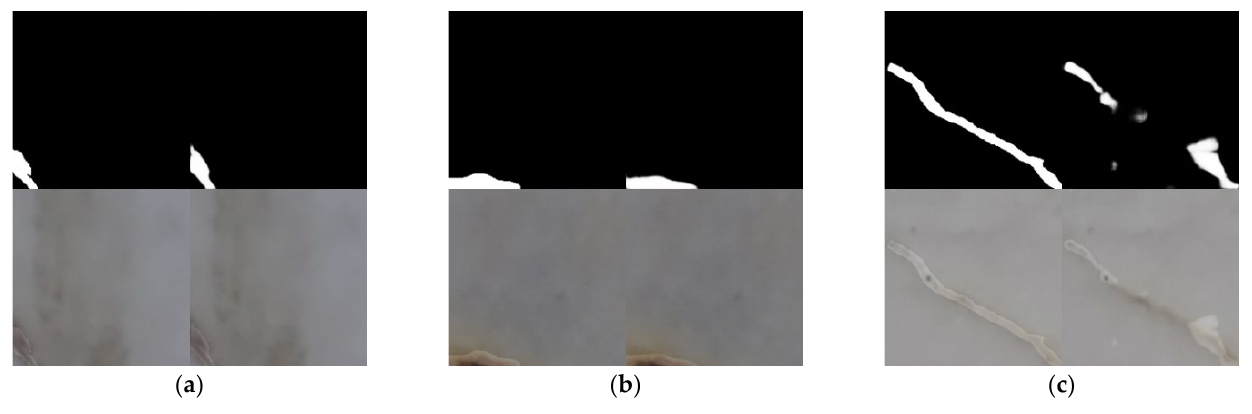
Figure 8. Indicative images of the testing set to illustrate LinkNet performance. For each image: up–